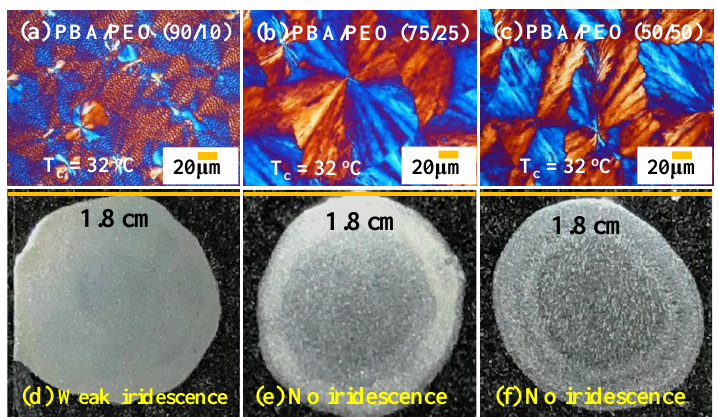
Figure 11. ( a – c ) Ringless birefringence patterns as viewed in POM, ( d – f ) weak or complete lack of iridescence from corrupted/irregular ring-banded or completely ringless or PBA (T c = 32 °C) crystallized from PBA/PEO blend of three different compositions: 90/10, 75/25, 50/50. By contrast, at a lower T c = 30 °C, with the compositions of the PBA/PEO blend being the same at 10, 25, and 50 wt.% of PEO, respectively, all PBA aggregates are orderly ring-